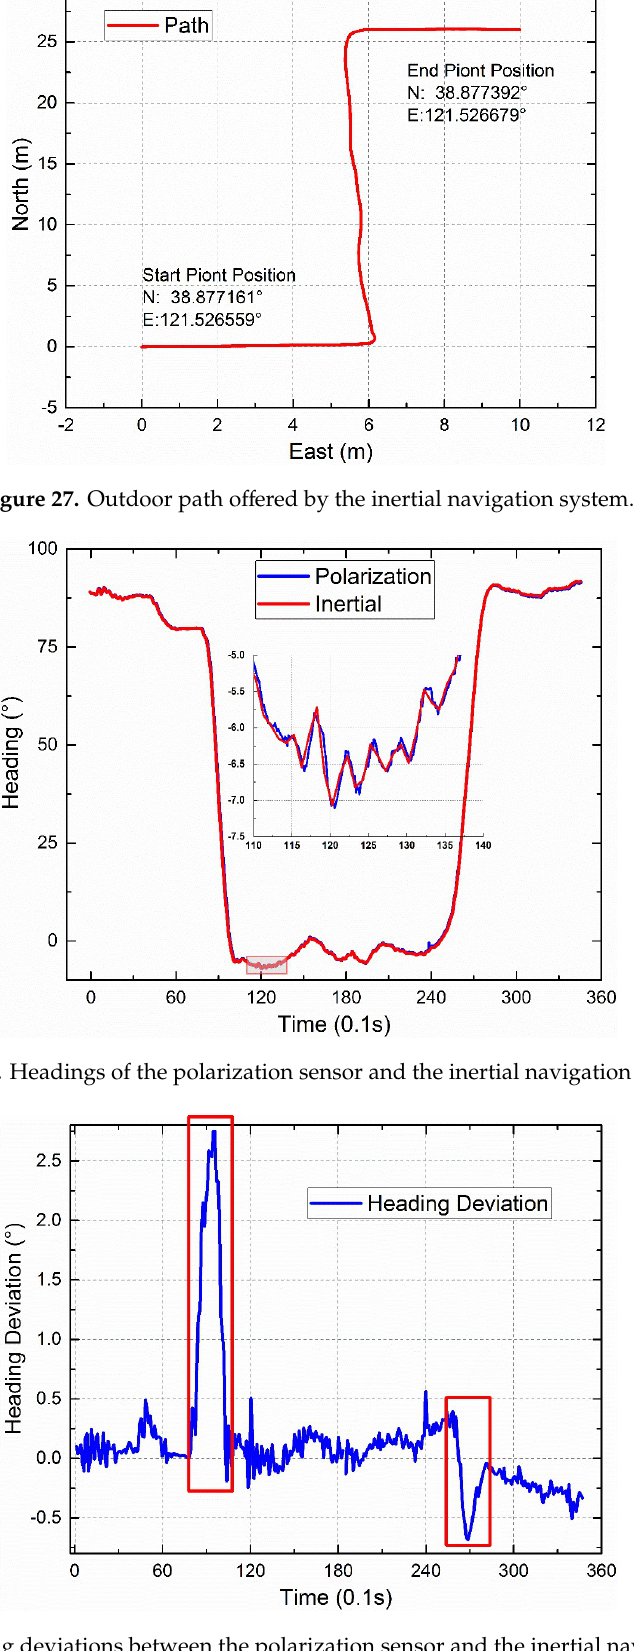
Figure 26. Photograph of dynamic outdoor setup.